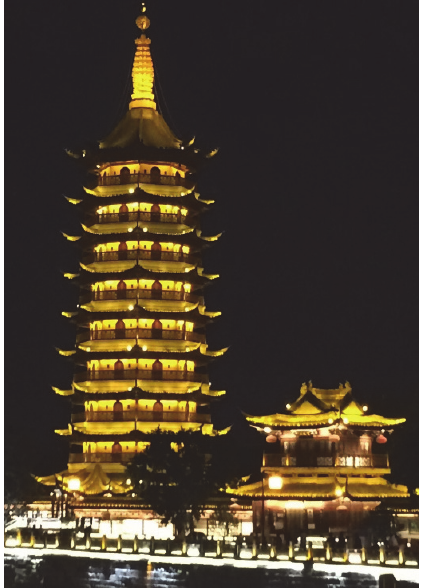
Figure 1: Wentong pagoda timber tower with nine floors is one heritage and beautiful monuments constructed in Huai’an city, Jiangsu province of